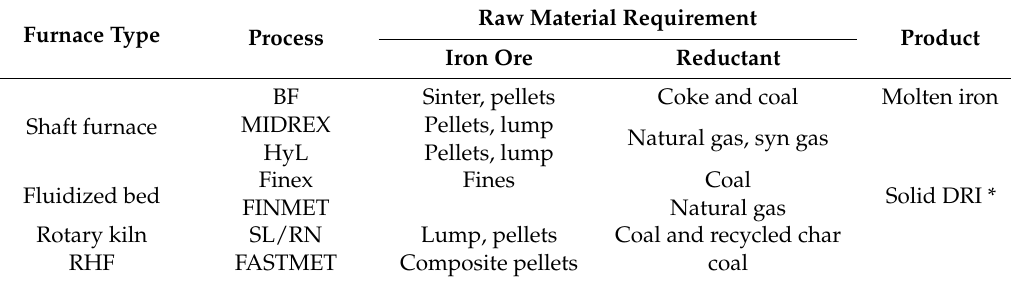
Table 1. Some commercial iron-making processes and their feed